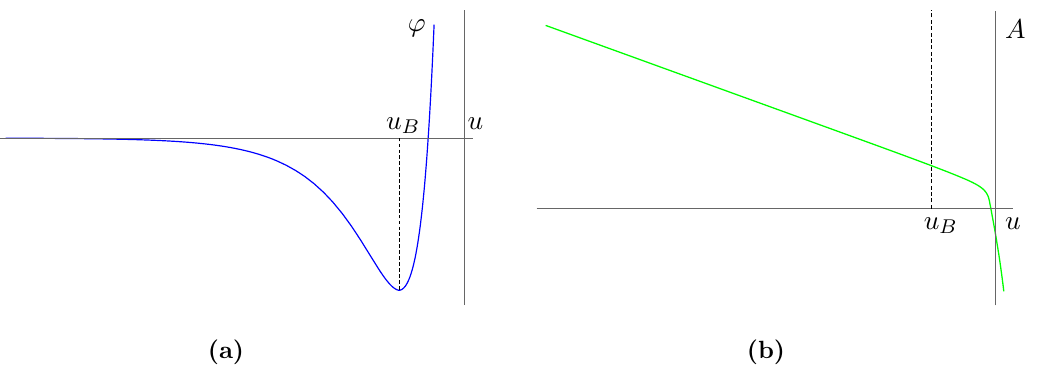
Figure 6. ’ and A vs. u for an example exhibiting a bounce at u = u B